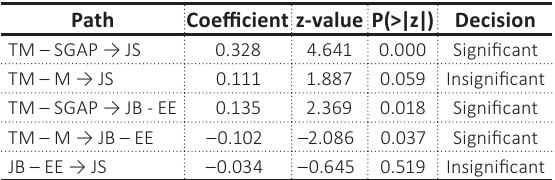
Table 5. Hypotheses testing